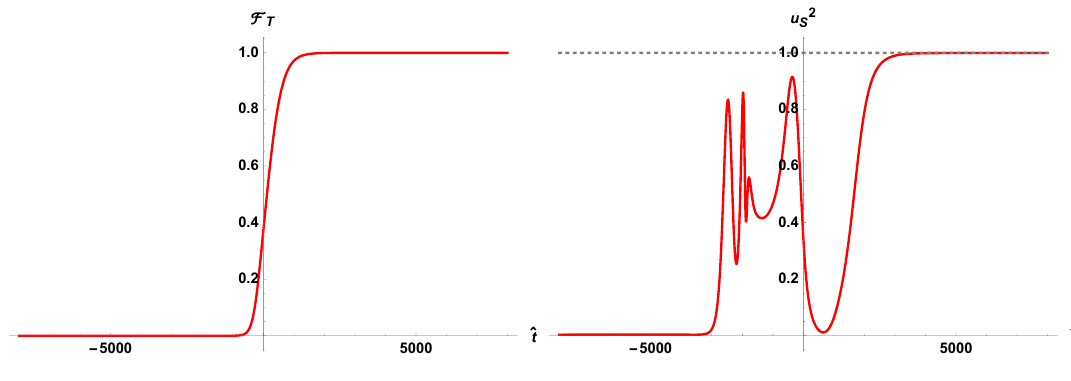
Figure 14 . Coefficient F T (left panel) and u 2 tion, bounce and subsequent GR